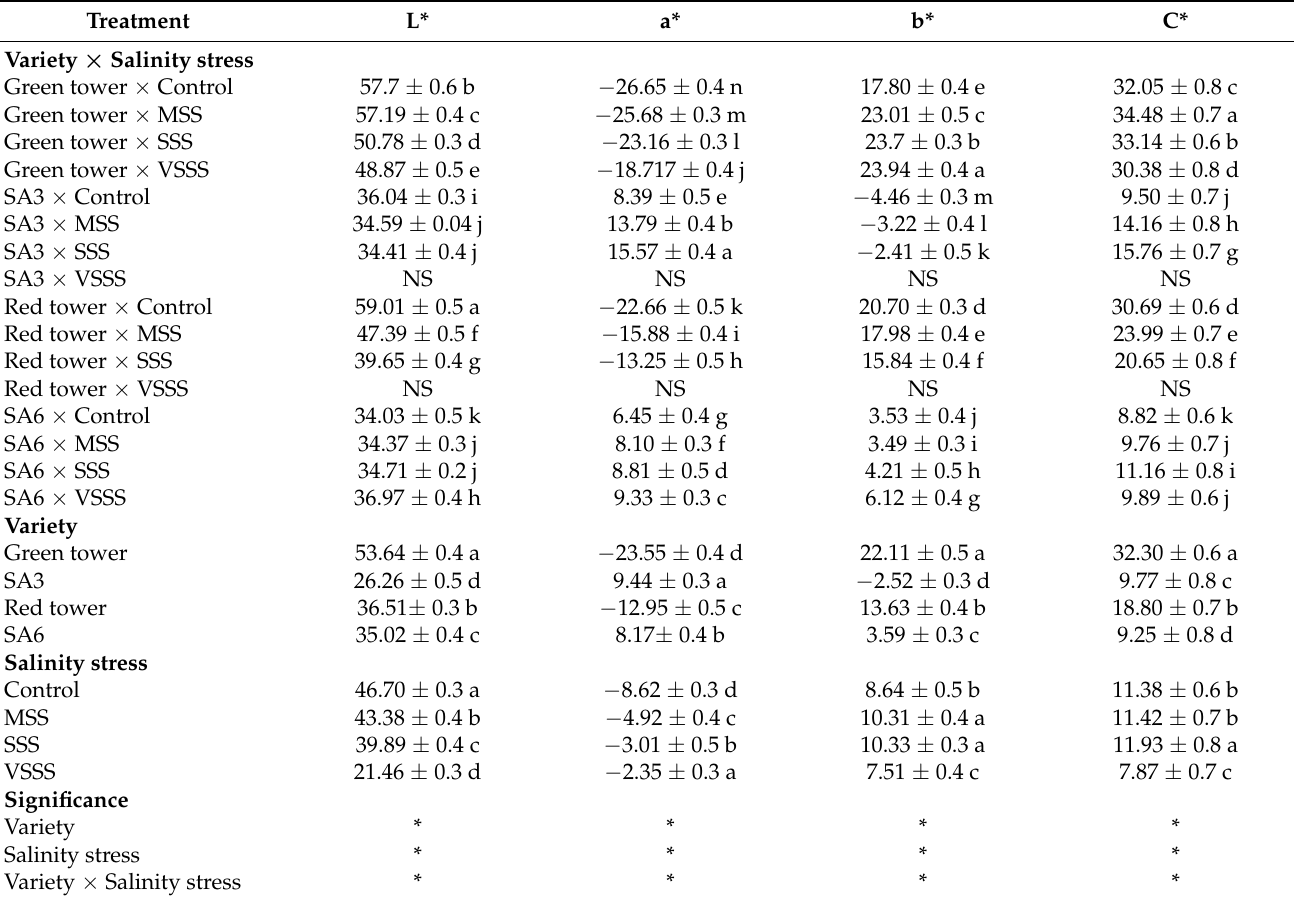
Table 1. Influence of salinity stress on leaf color parameters in four selected genotypes of A. lividus leafy